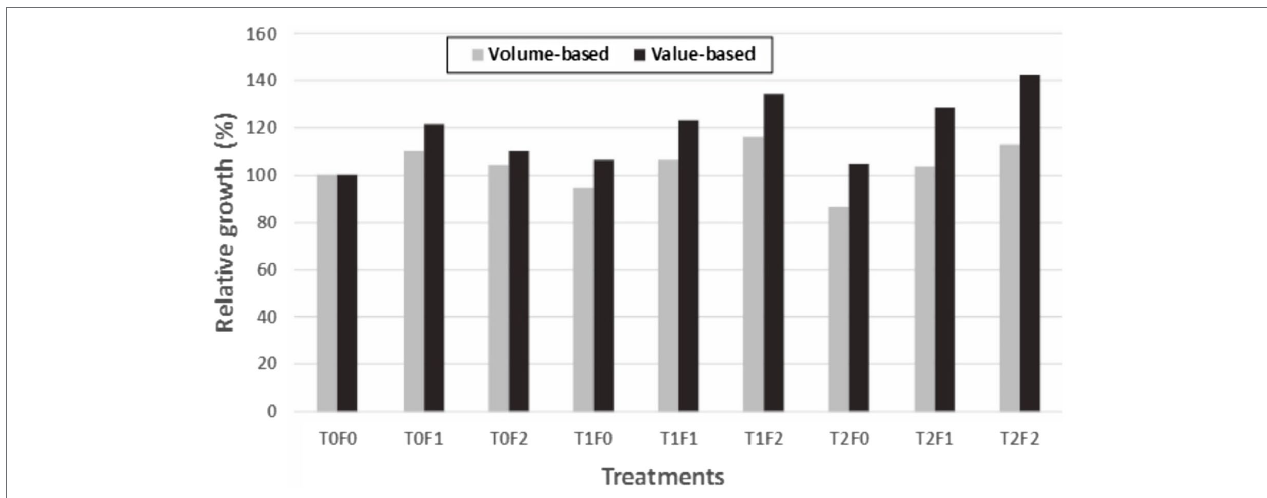
FIGURE 9 | Commodity value-based vs. volume-based growth estimates for Douglas-fir ( Pseudotsuga menziesii Mirbel) trees relative to untreated sites (as 100%) for different treatment combinations, 40 years after application at the Shawnigan Lake trial in British Columbia, Canada.T0, T1, and T2 correspond to 0, 1/3, and 2/3 basal area removal, respectively. F0, F1, and F2 correspond to 0, 224, and 448 kg N/ha fertilization with urea,